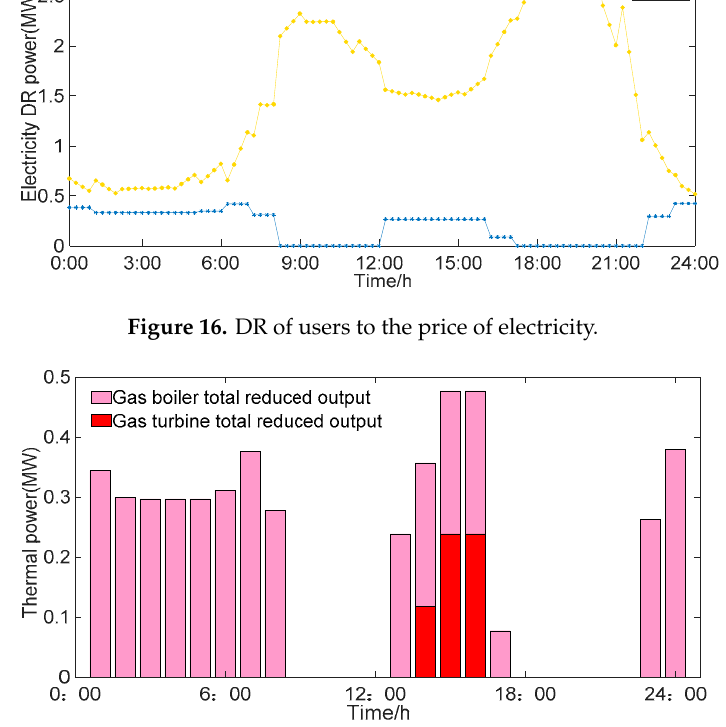
Figure 17. Changes in unit thermal output after user DR.